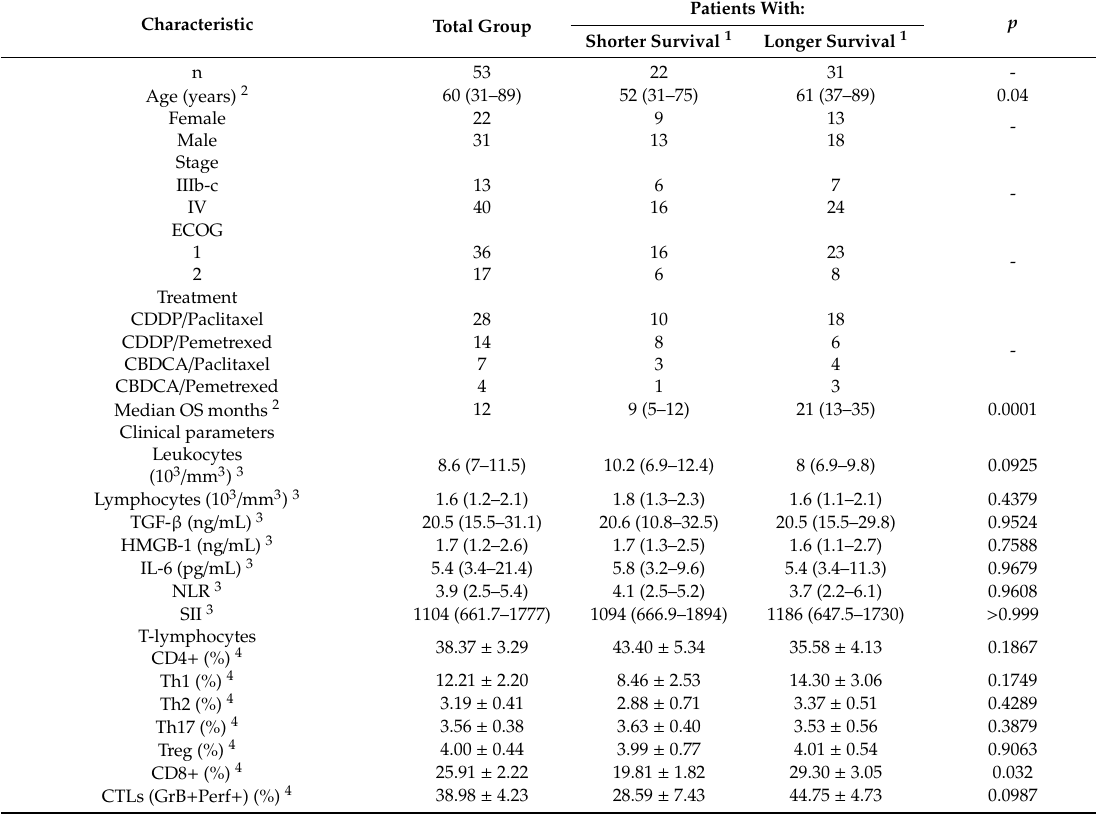
Table 1. Demographic and baseline characteristics of lung cancer